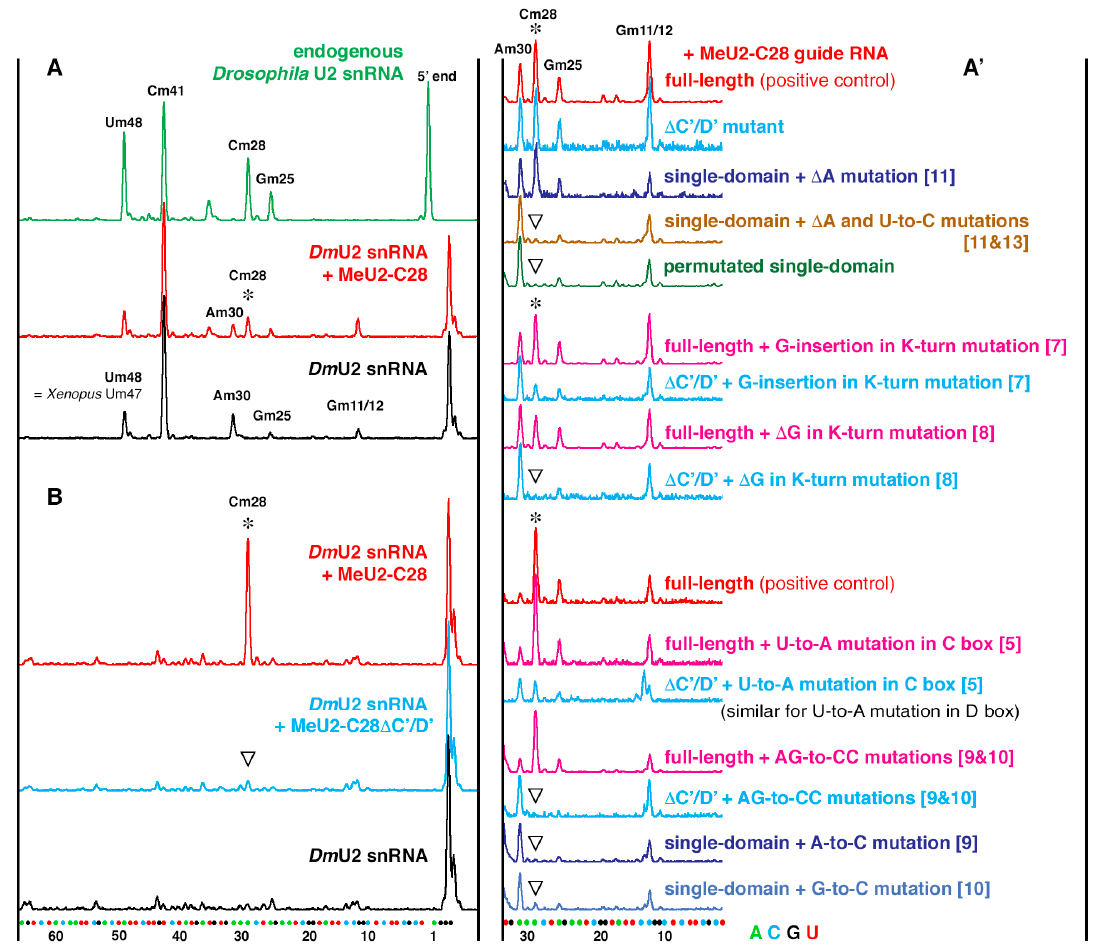
Figure 3. Mapping 2’- O -methylation of Drosophila U2 snRNA in in vitro modification assays. When dNTPs are used at low concentration, reverse transcriptase pauses at 2’- O -methylated positions and short fragments accumulate. The fluorescently labeled fragments appear as peaks above the baseline. The relative height of the peaks is significant only when oocytes from the same frog were used and modification assays were run at the same time (grouped traces). ( A ) 2’- O -methylation of endogenous Drosophila U2 snRNA (green trace) and in vitro-transcribed Drosophila U2 injected into Xenopus oocytes, either alone (black trace) or with in vitro-transcribed Drosophila MeU2-C28 guide RNA (red trace). Endogenous Drosophila U2 snRNA is modified at positions 48, 41, 28 and 25. When injected into Xenopus oocytes, Drosophila U2 snRNA becomes modified by the endogenous Xenopus modification machinery at position 30, specific to vertebrate U2 snRNA, but not at Drosophila -specific position 28. Vertebrate-specific 2’- O -methylation at positions 11 and 12 is also detected in Drosophila U2 snRNA injected into Xenopus oocytes (black trace). For more details on U2 snRNA modification patterns in vertebrates and Drosophila , see Supplementary Figure S1. Co-injection of MeU2-C28 induces 2’- O -methylation at position 28 (red trace, star). ( A’ ) Zoom-in on the region of MeU2-C28-inducible modification. Traces show modification activity of representative mutants of MeU2-C28 guide RNA. Induced 2’- O -methylation at C28 is indicated with a star; unmodified C28 is indicated with an open arrowhead. ( B ) MeU2-C28 modification activity in RNA-depleted nuclear extract. Wild-type MeU2-C28 (top red trace) is functional in this assay, but the ∆ C’ / D’ mutant (blue trace) and other shorter mutants are not. As previously shown, the ∆ CAB mutant is also functional in this assay [13].